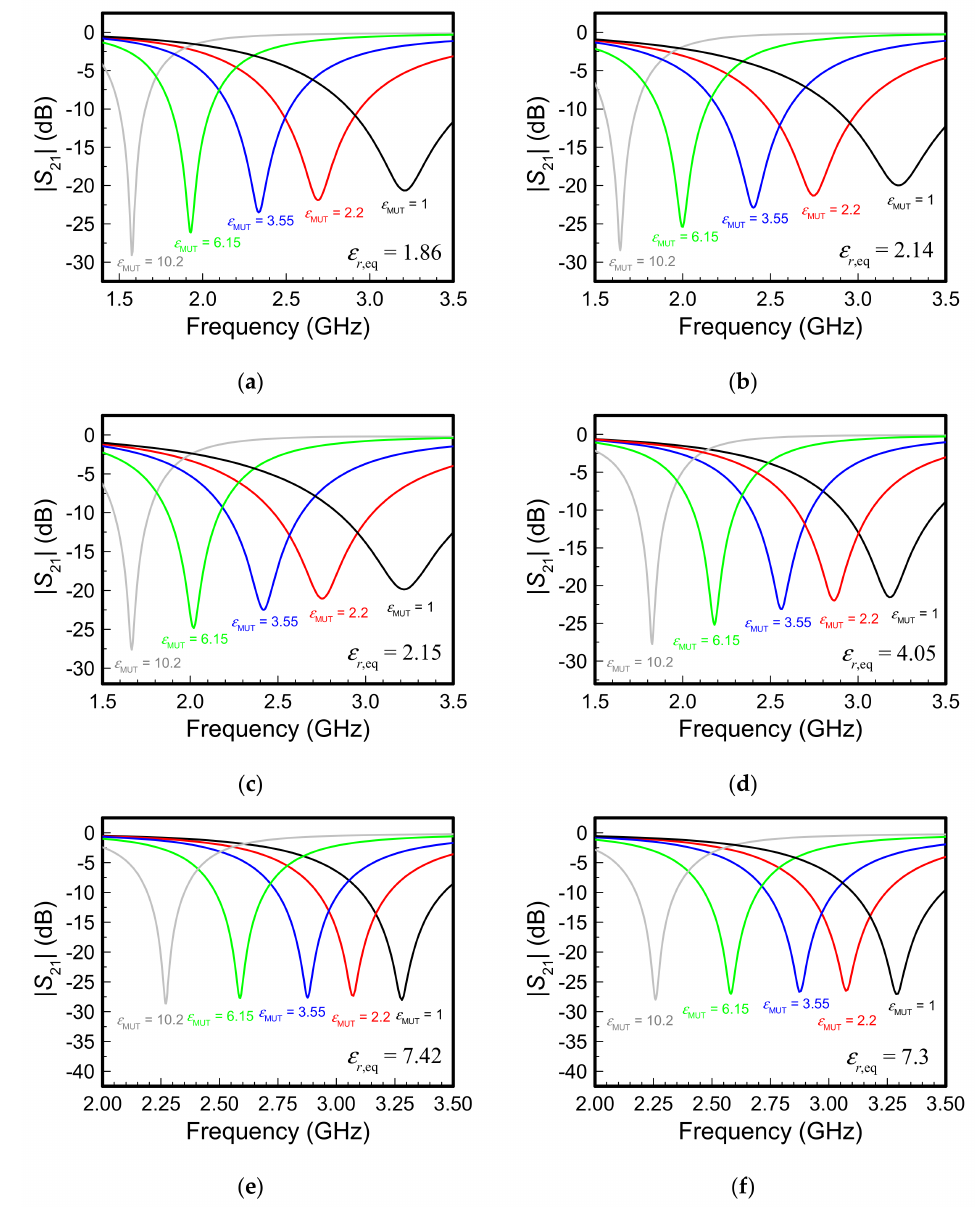
Figure 4. Responses of the sensors for different dielectric constants of the material under test (MUT) (indicated). ( a ) Sensor A; ( b ) sensor B; ( c ) sensor C; ( d ) sensor D; ( e ) sensor E; ( f ) sensor